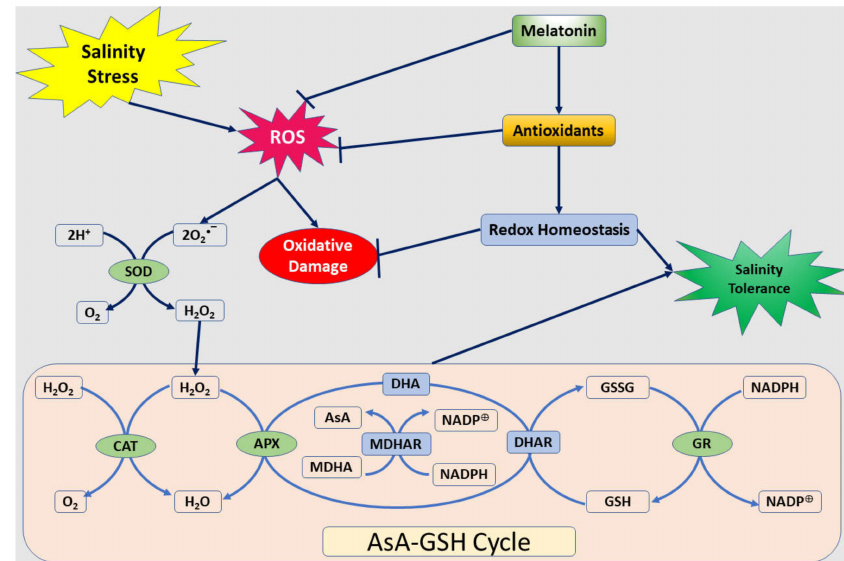
Figure 7. Schematic presentation of the ascorbate–glutathione cycle and a model depicting the melatonin-induced alleviation of NaCl-caused oxidative stress in peanut plants. Abbreviations: ROS, reactive oxygen species; SOD, superoxide dismutase; CAT, catalase; APX, ascorbate peroxidase; AsA, ascorbate; MDHA(R), monodehydroascorbate (reductase); NADPH, nicotinamide adenine dinucleotide phosphate, DHA, dehydroascorbate; DHAR, dehydroascorbate reductase; GSH, reduced glutathione; GSSG, oxidized glutathione; and GR, glutathione